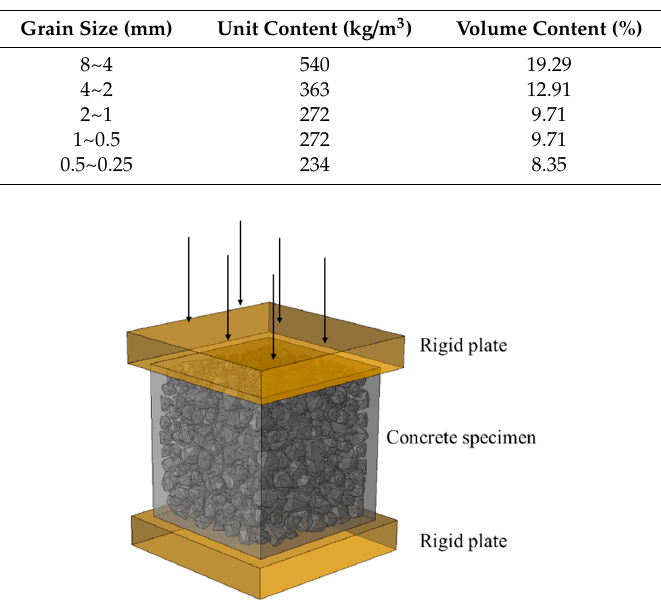
Figure 7. Loading scheme of the concrete